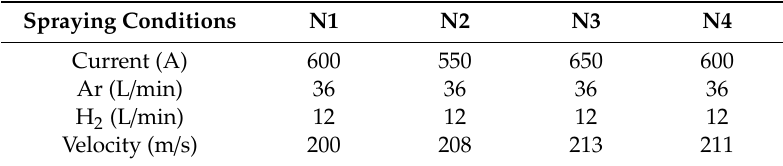
Table 1. Plasma spray